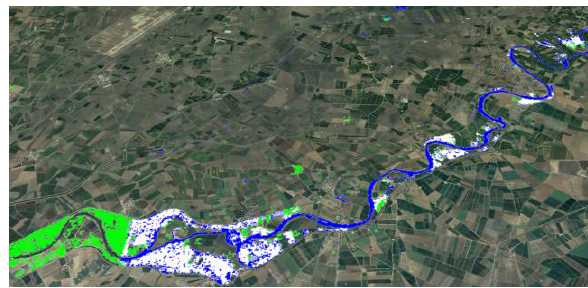
Table 6. Spot and SAR Flooded Area Legend